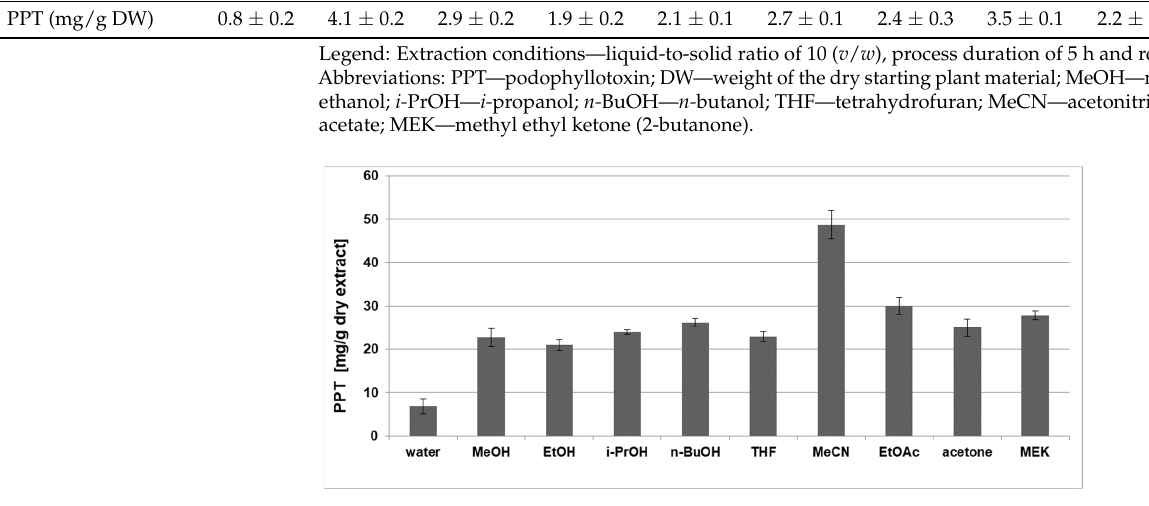
Figure 1. Effect of the solvent type on the PPT concentration relative to the weight of the dry juniper leaf extracts. The used polar solvents were water, methanol (MeOH), ethanol (EtOH), i- propanol ( i -PrOH), n- butanol ( n- BuOH), tetrahydrofuran (THF), acetonitrile (MeCN), ethyl acetate (EtOAc), acetone and methyl ethyl ketone (MEK, 2-butanone). Other extraction parameters—liquid-to-solid ratio of 10 ( v / w ), process duration of 5 h and room temperature.